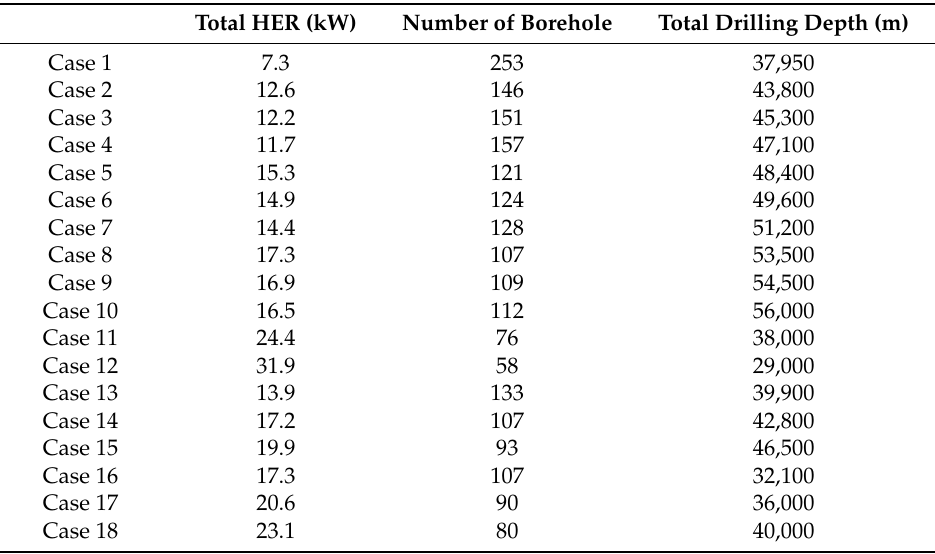
Table 7. Number of drilled boreholes and drilled depth of each case.